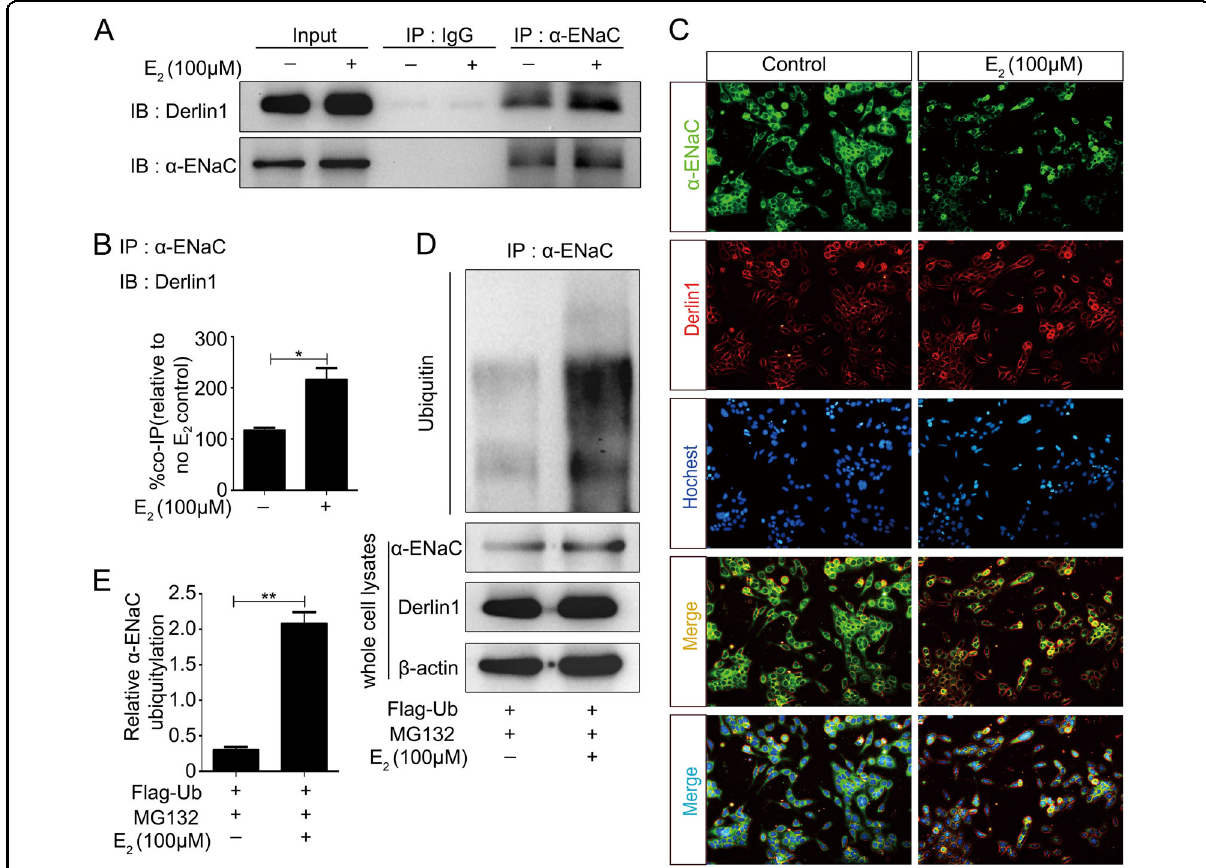
Fig. 6 Estrogen induces α -ENaC ubiquitination by promoting the interaction of α -ENaC with derlin-1. a The interaction between α -ENaC and derlin-1 was detected through co-IP analysis in mpkCCDc14 cells with or without E 2 stimulation. b Quanti fi cation of the binding signals from ( a ). c Double immuno fl uorescence staining was performed to con fi rm the interactions between α -ENaC and derlin-1 in mpkCCDc14 cells with or without E 2 treatment. d More ubiquitin conjugated to α -ENaC was detected in cells treated with E 2 than in untreated cells. e Quanti fi cation of the ubiquitin conjugated to α -ENaC shown in d normalized to β -actin expression